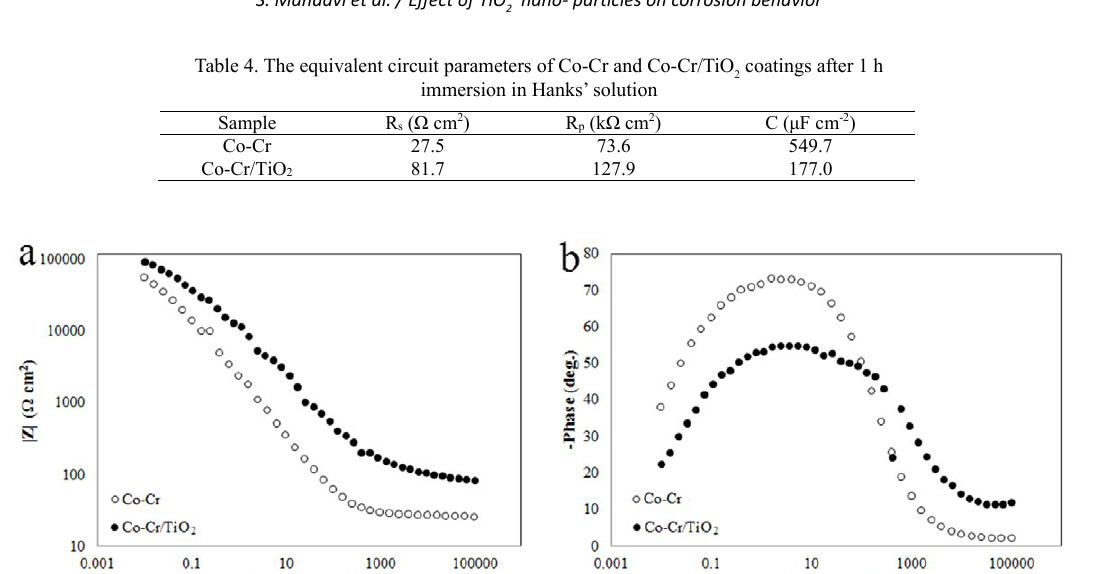
Fig. 6. Bode plots of electrodeposited Co-Cr and Co-Cr/TiO 2 coatings.